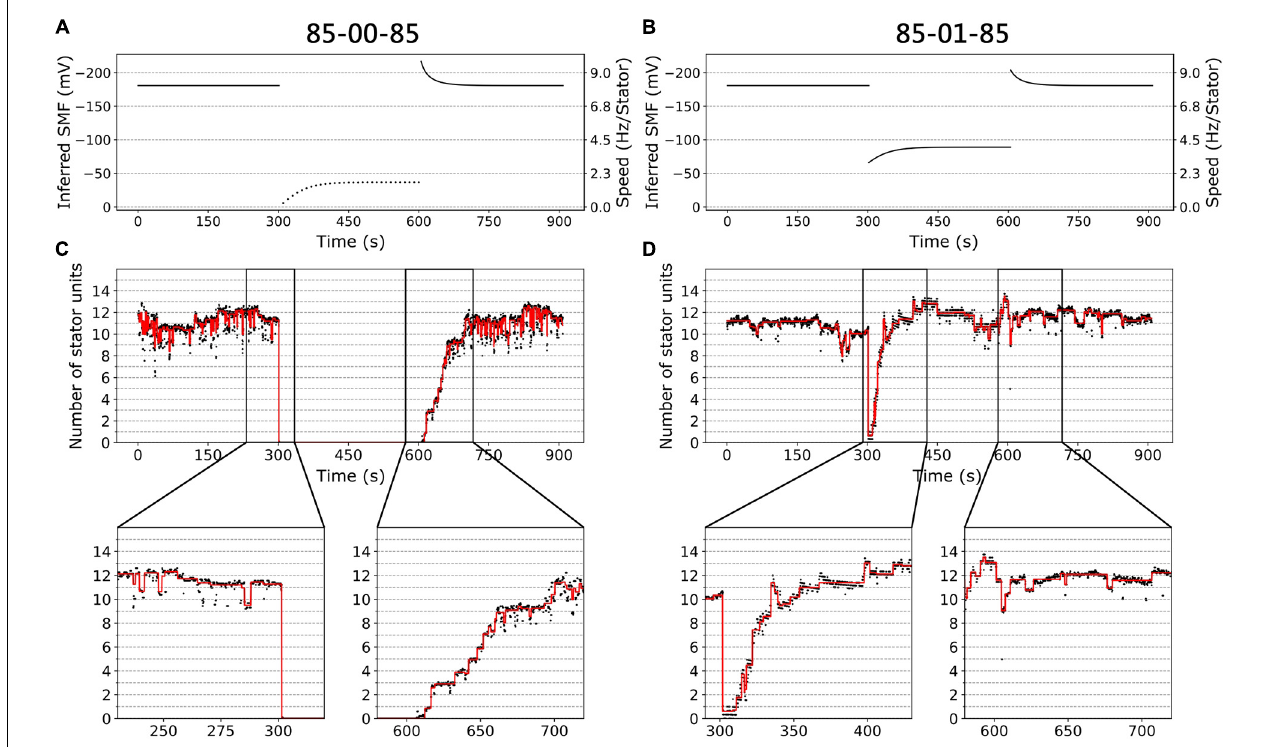
FIGURE 3 | BFM speed and stator dynamics. (A) The inferred SMF as a function of time for experiment 85-00-85 mM sequence. The dotted line represents an estimated SMF with the assumption of nonzero [Na + ] ex = 0.08 mM because the sodium gradient term is undefined at zero sodium ion concentration. The right-hand-side y axis shows the speed per stator unit. (B) The inferred SMF as a function of time for experiment 85-01-85 mM sequence. (C) The stator unit number of a representative trace in an experiment with 85-00-85 mM sequence, same data in Figure 1D . The insets are the magnification of transition courses (rectangle region). The red line is the stator number filtered by the edge-preserving Chung–Kennedy filter (Chung and Kennedy, 1991) and was stepped by Student t test (Leake et al., 2004). (D) The stator unit number of a representative trace in experiment 85-01-85 mM sequence, same data in Figure 1D